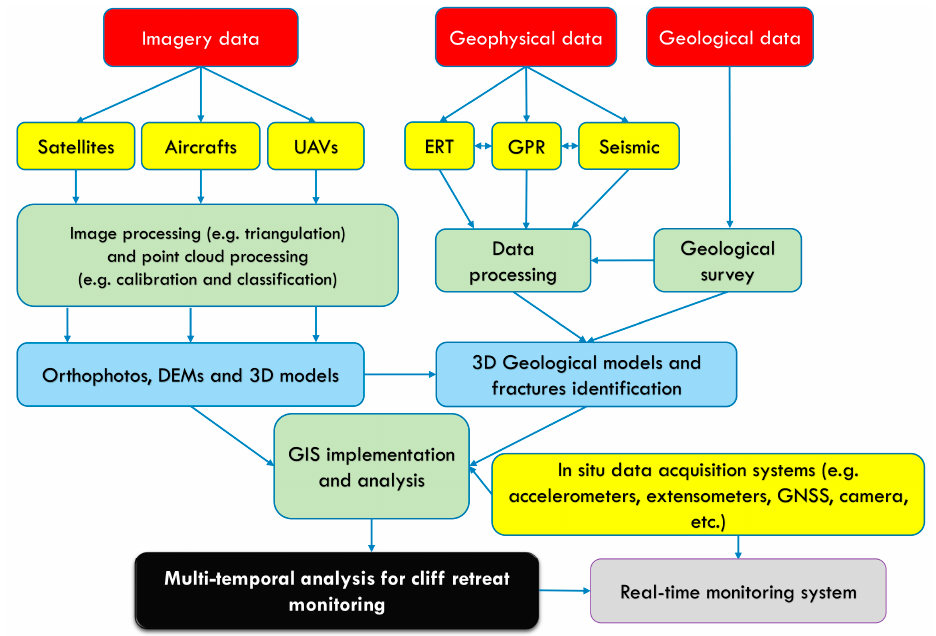
Figure 12. Schematic sketch for early warning system for cliff failure .